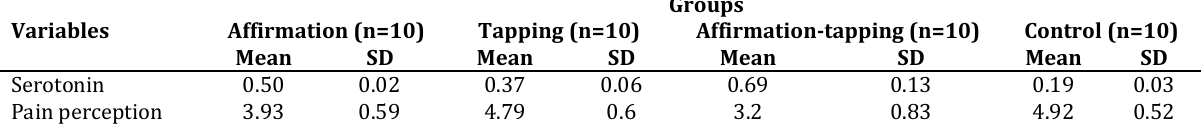
Table 2. Serotonin levels (ng / mL) and pain perception per group (n=40)